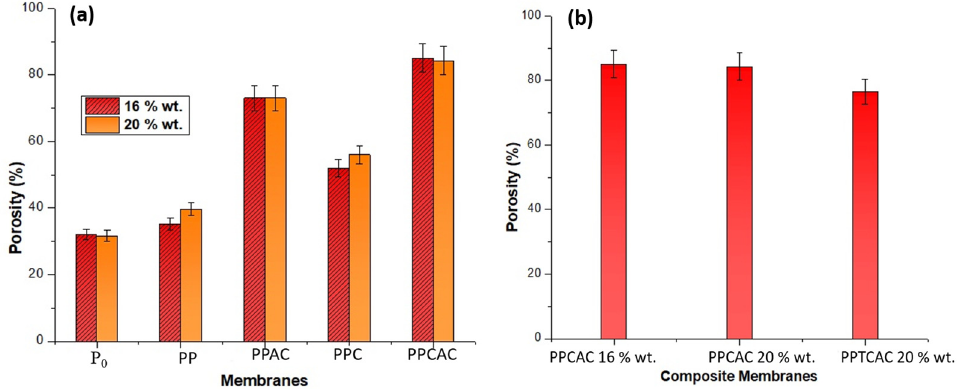
Figure 8. Porosity bar graph for ( a ) 16 and 20% PES membranes, and ( b ) composite